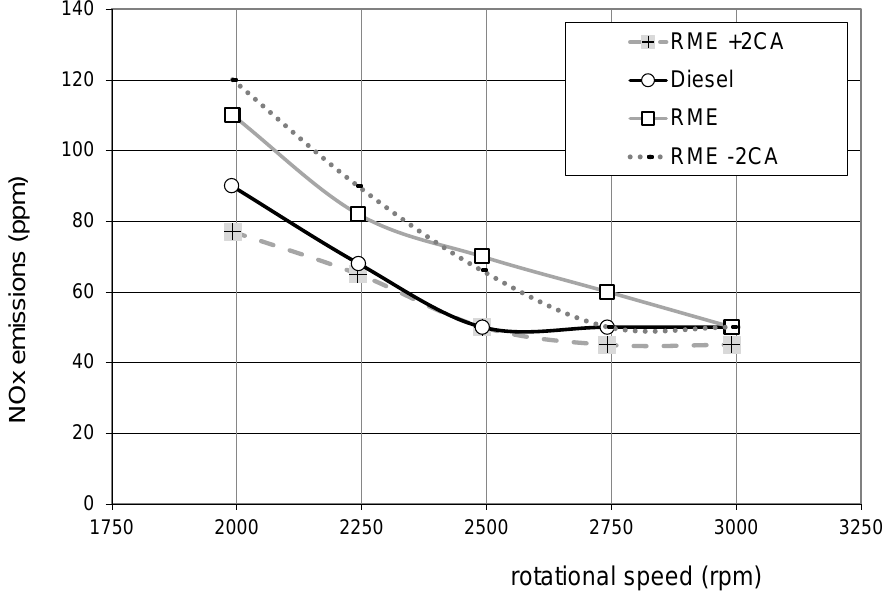
Figure 23. NO x emissions variations for the biodiesel at different values of the SOI and at full load (ref. diesel emissions with 16° CA of injection advance).